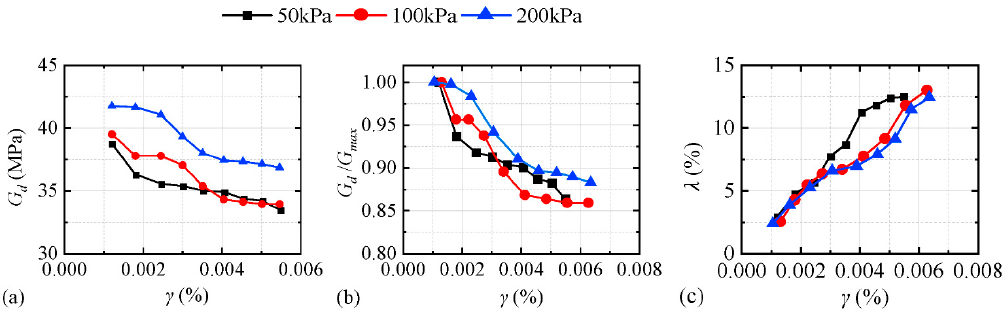
Figure 5. Test results of rubber powder soil: ( a ) Dynamic shear modulus, ( b ) Normalized dynamic shear modulus, ( c ) Dynamic damping ratio.